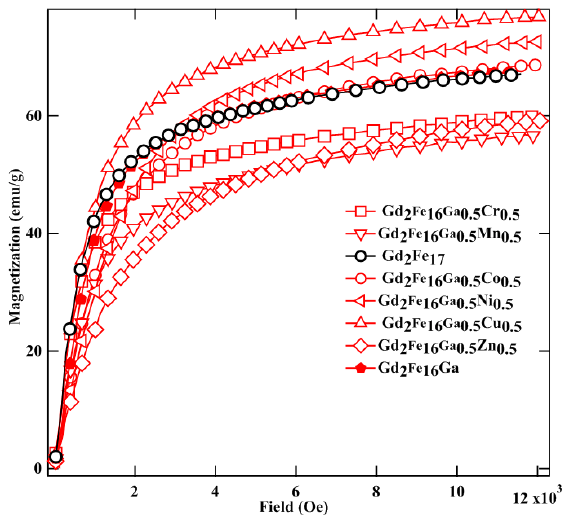
Figure 4. Room temperature M vs. H plot of Gd 2 Fe 17 and Gd 2 Fe 16 Ga 0.5 TM 0.5 (TM = Cr, Mn, Co, Ni, Cu, Zn, and Ga).